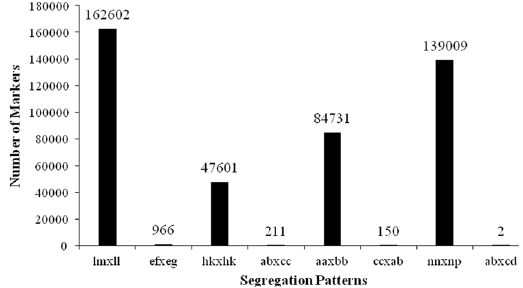
Figure 1. Statistics of genotyped GBS markers in eight segregation